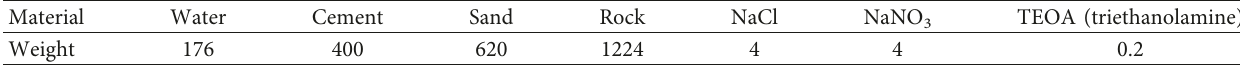
Table 2: Mix proportion of the shaft concrete (kg/m 3 ).